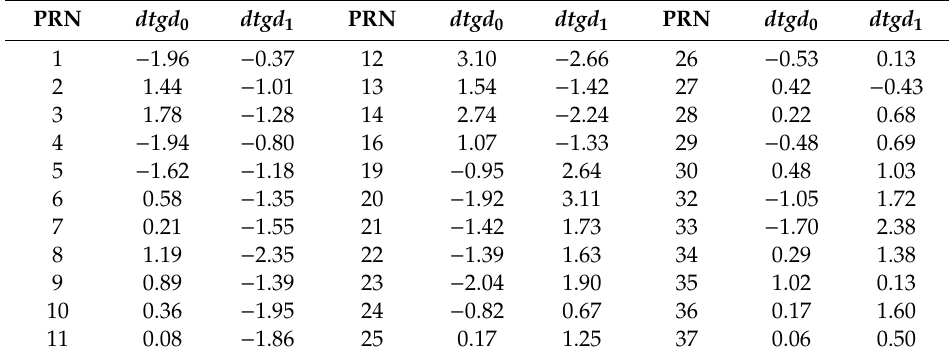
Table 5. Calibrated BDS TGD bias from network solution (in ns). dtgd 0 means the TGD bias at B3I frequency, and dtgd 1 is the residual TGD bias of TGD 1 .